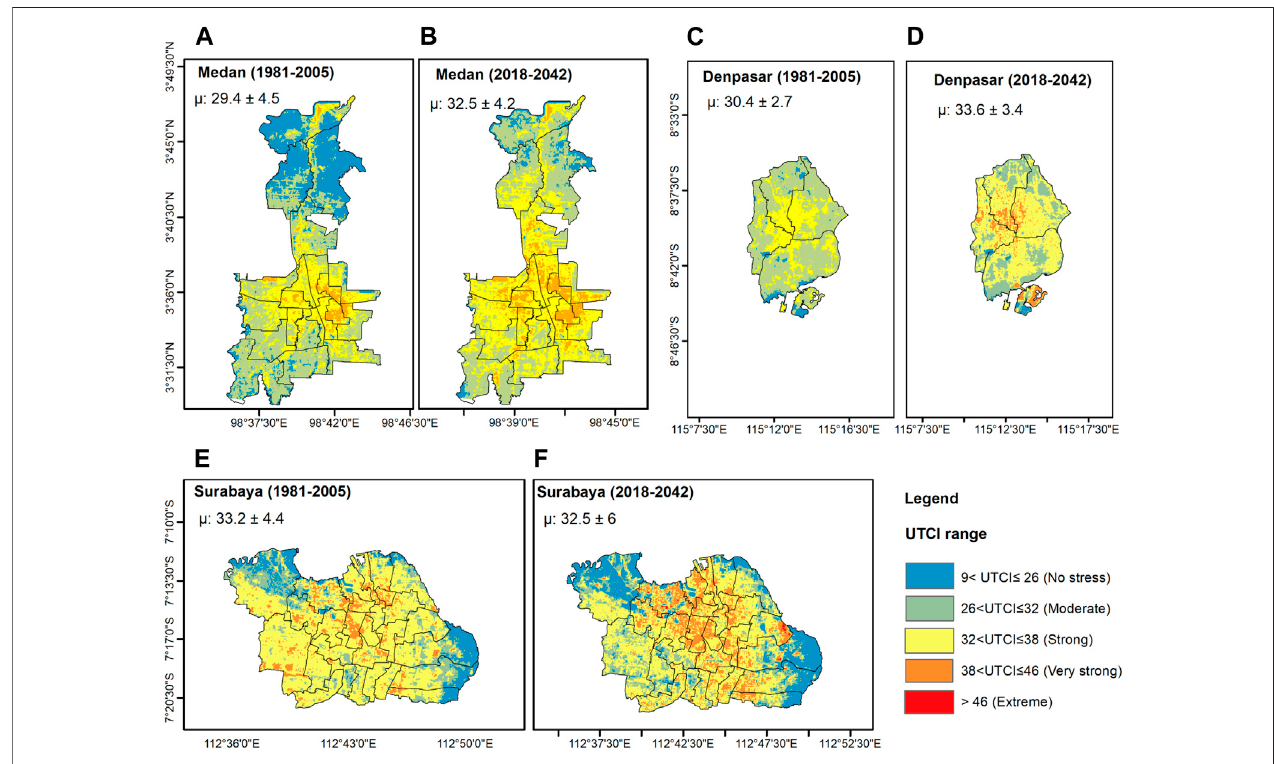
FIGURE 5 | UTCI spatial distribution in Medan, Denpasar, and Surabaya, LC scenario. The (A, C, E) refer to the baseline period of Medan, Denpasar, and Surabaya, while (B, D, F) are the future period of Medan, Denpasar, and Surabaya under the LC scenario.